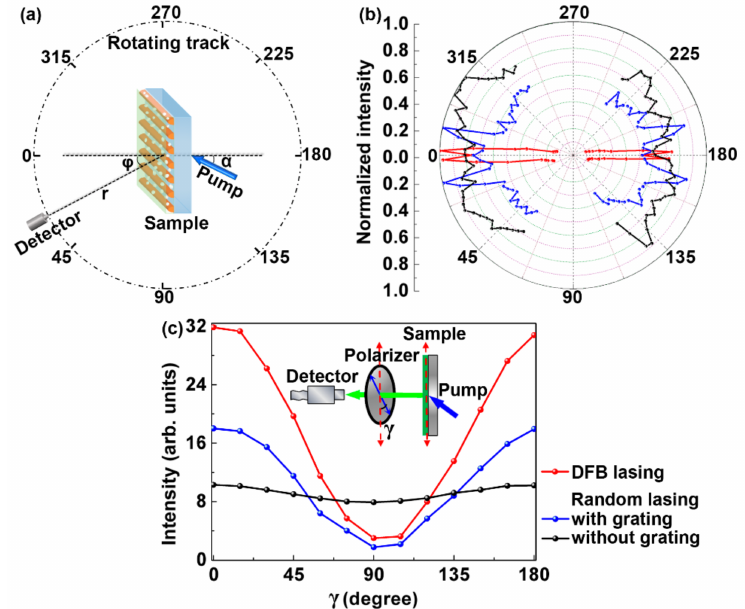
Figure 4. ( a ) Schematic of the emission spectra measurement at different angles ( φ ). α = 20 ◦ . r = 30 mm. ( b ) Measured angular emission spectra of the DFB lasing (the red curve) and the random lasing (the blue curve) in a compound cavity. The black curve shows the angular spectra of the random laser without grating. All spectra were measured within 60 degrees ( φ < 60 ◦ ). ( c ) The polarization state of the random laser with (the red curve) and without (the black curve) the grating. The inset shows the measurement setup. γ is the angle between the grating groove direction (shown by the red arrow) and the polarization direction of the polarizer (shown by the blue arrow). The polarization state of the DFB laser is indicated by the blue